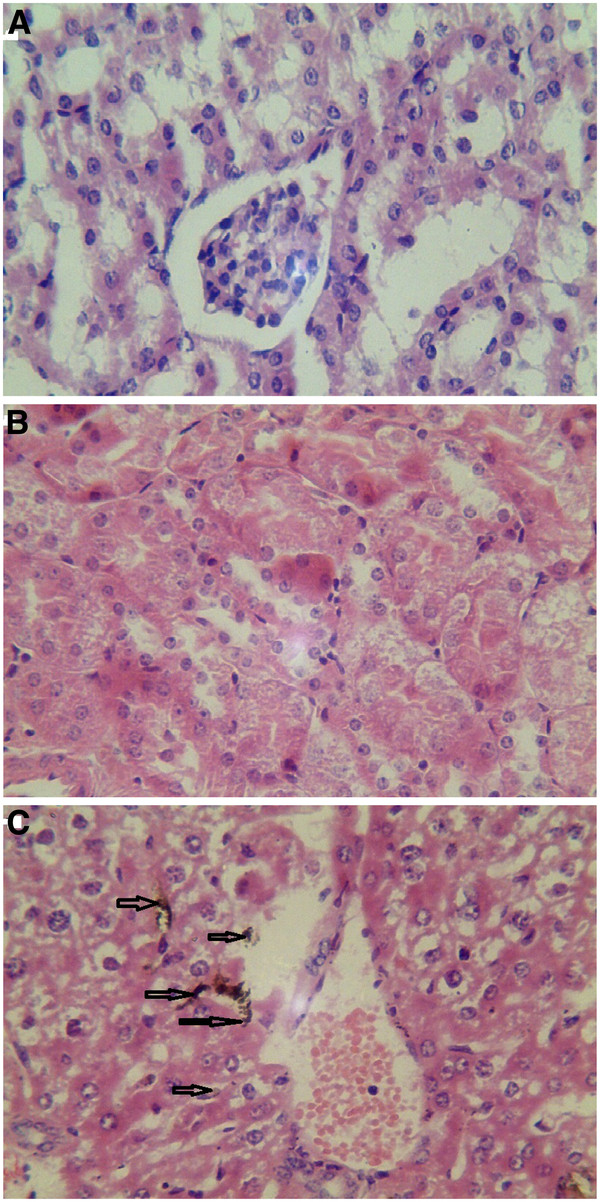
The histology of kidney tissues (×20). (A) oMWCNTs, (B) NDs, and (C) oMWCNTs + NDs.